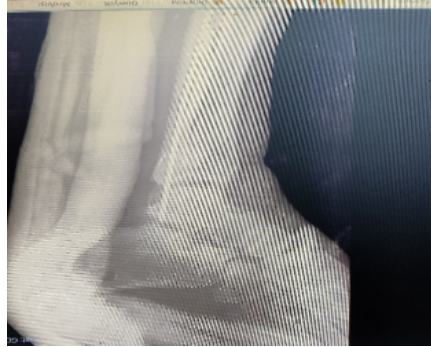
Figure 8. removal of external fixator after 4 month-Lateral view